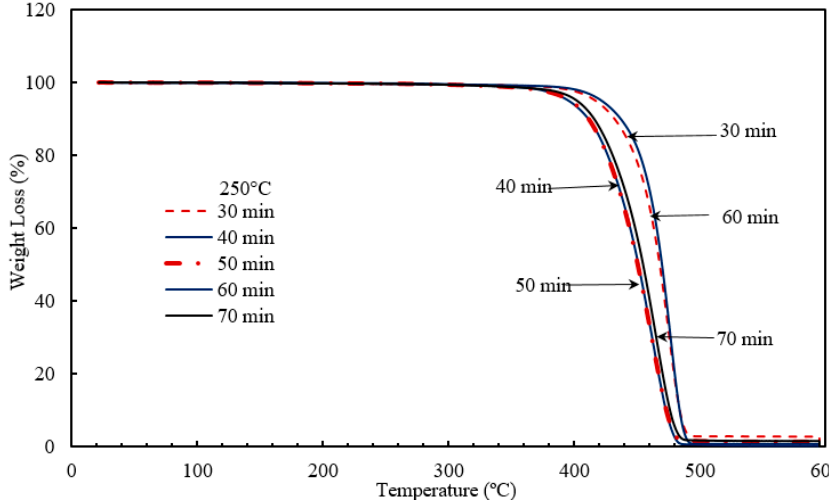
Figure 16. Pictorial representation of TGA analysis carried out on HDPE-TiO 2 with varying residence time.